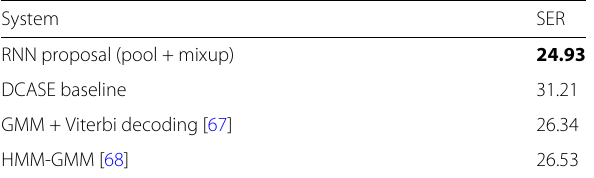
Table 13 SER on the Albayzín 2012 test partition for different systems proposed in the literature compared to our